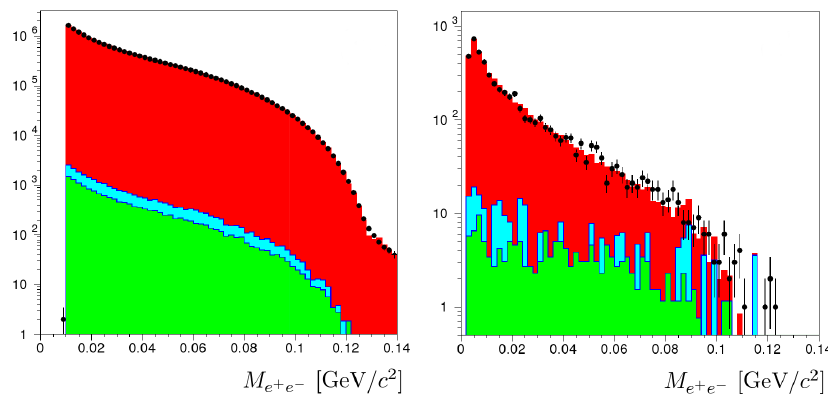
Figure 4. Reconstructed e + e − invariant mass distributions for the normalization π ± π 0 D candidates (left) and for the signal π ± π 0 e + e − events (right). Full dots correspond to data candidates. Stacked histograms on the left plot are, from bottom to top, the expected K µ 3 D and K e 3 D backgrounds and the normalization distribution. Stacked histograms on the right plot are, from bottom to top, the expected K 3 π D and K 2 π D backgrounds and the signal IB simulation